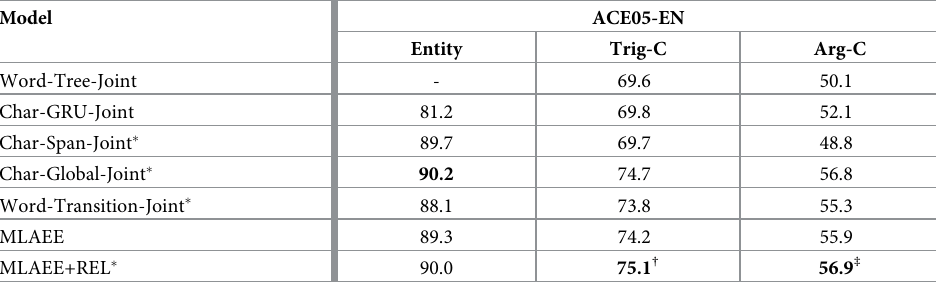
Table 2. Comparison results on